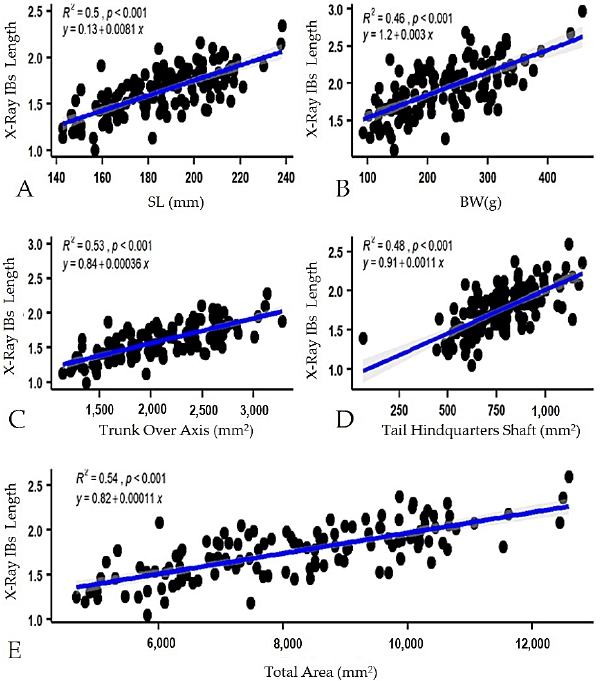
Figure 7. Effects of growth parameters in: ( A ) SL (mm); ( B ) BW (g); ( C ) trunk over axis (mm 2 ); ( D ) tail hindquarters shaft (mm 2 ); ( E ) total area (mm 2 ) on IB length from X-ray imaging in tambaqui Colossoma macropomum . Regression lines are calculated from coefficients from linear model, after Box–Cox transformation for normalization of data and 95% confidence level of fitted values. R 2 are the coefficients of determination adjusted accounting for specifical effects.